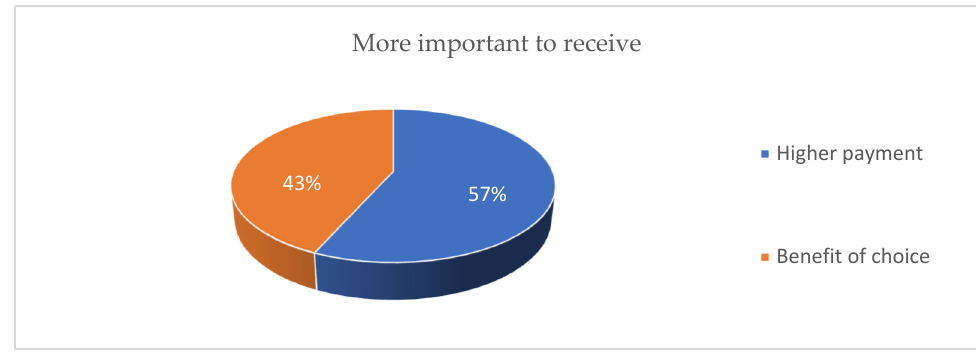
Figure 3. Percentage of employees who prefer a higher pay compared to the benefit of their choice.